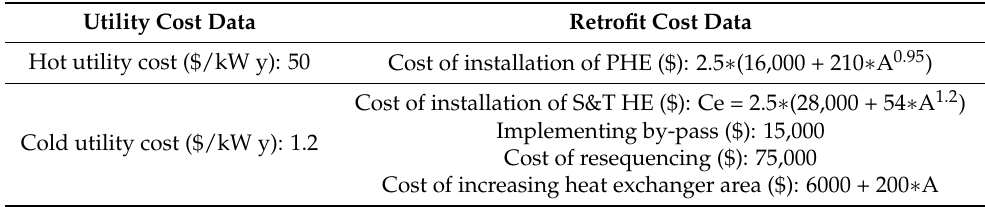
Table 1. Cost data for case studies.